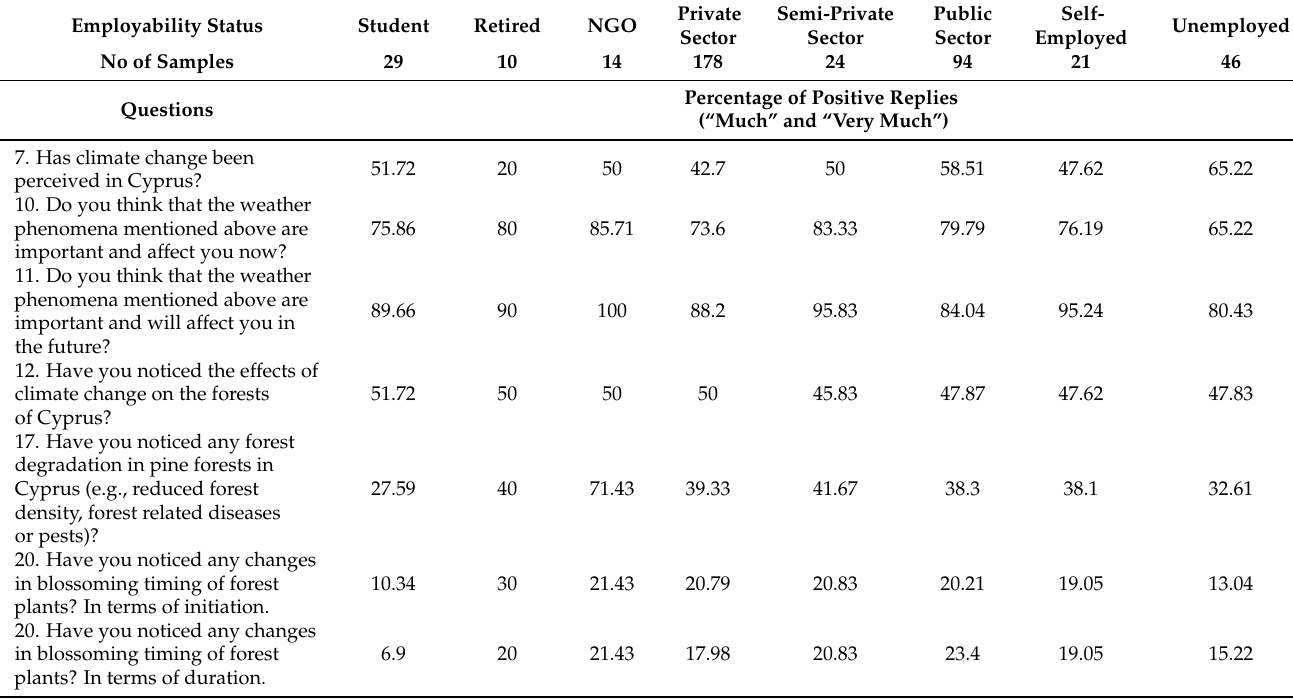
Table 7. Percentage of positive (“Much” and “Very Much”) replies of the Likert Questions according to the employability status of the